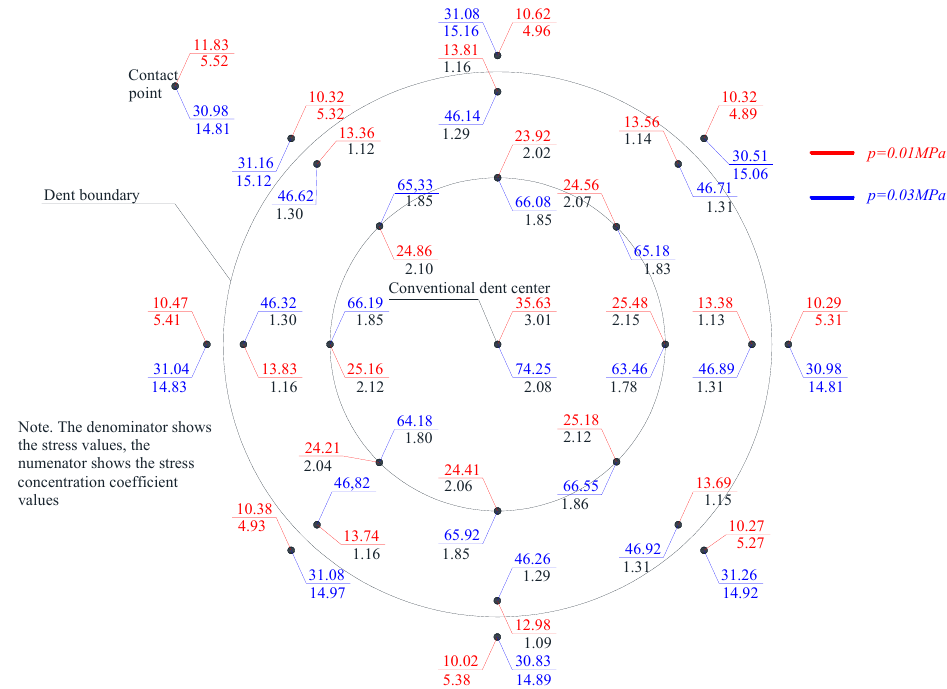
Figure 5. Distribution of hoop stresses at characteristic dent zone points in the wall of the model M1 ‐ A.